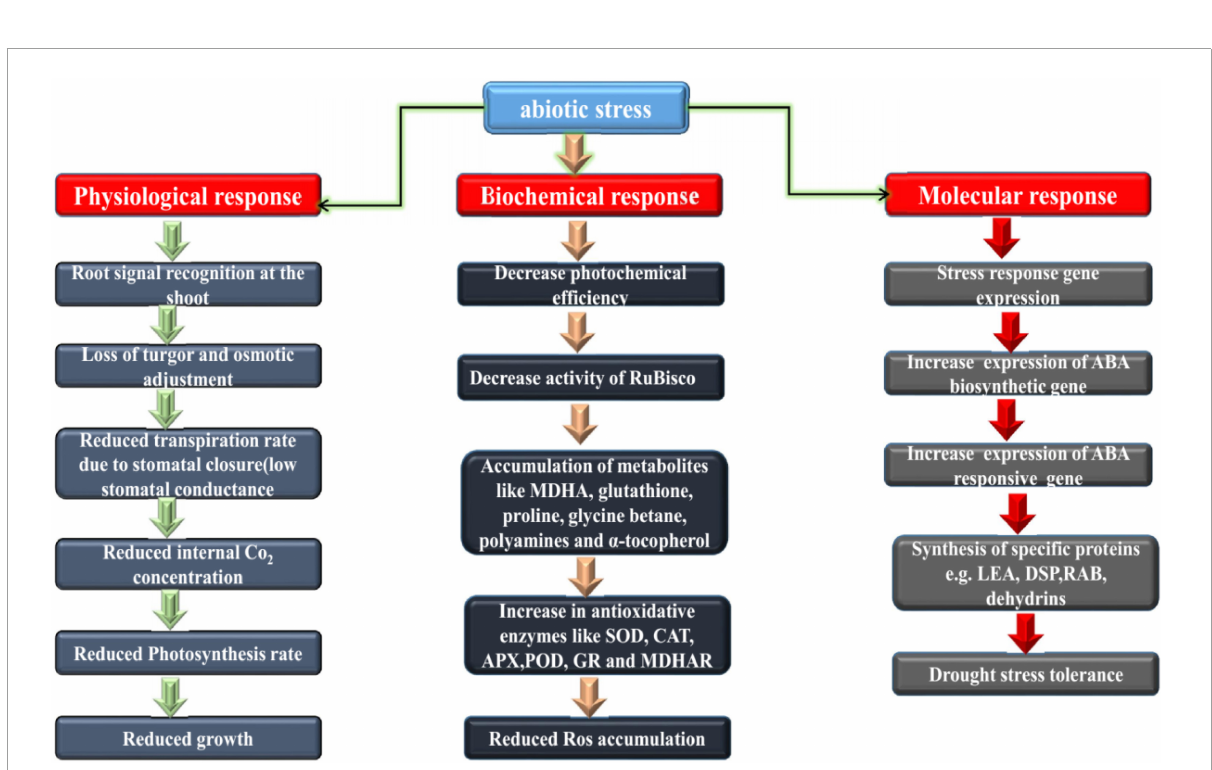
FIGURE2 Physiological, biochemical and molecular basis of drought resistance in plants. Both major and minor changes that occur downstream of the transcriptional regulatory